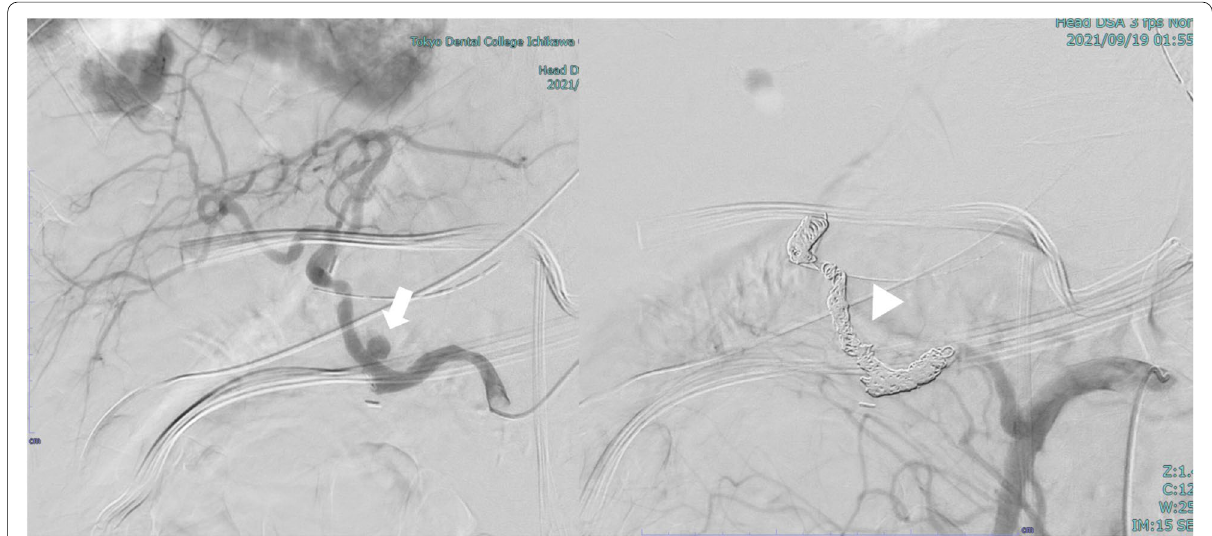
Fig. 1 The common hepatic artery branched from the superior mesenteric artery; additionally, a pseudoaneurysm was observed in the proper hepatic artery (white arrow). Tight coil embolization was performed, which led to total occlusion of the native hepatic arterial flow (white arrowhead). Stent-graft placement was not performed due to the fact that the common hepatic artery branched with acute bending. In this case, a brachial approach might be effective if stent grafts are